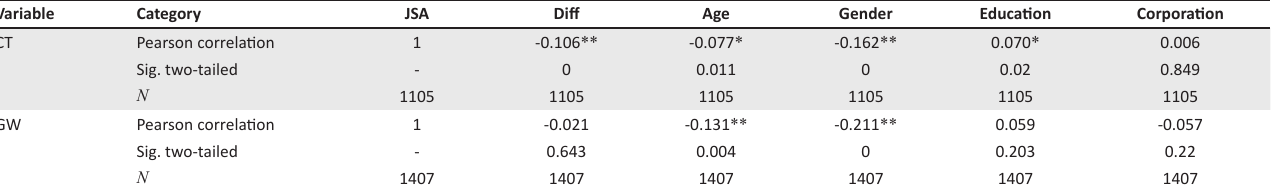
TABLE 2: Pearson correlations result.